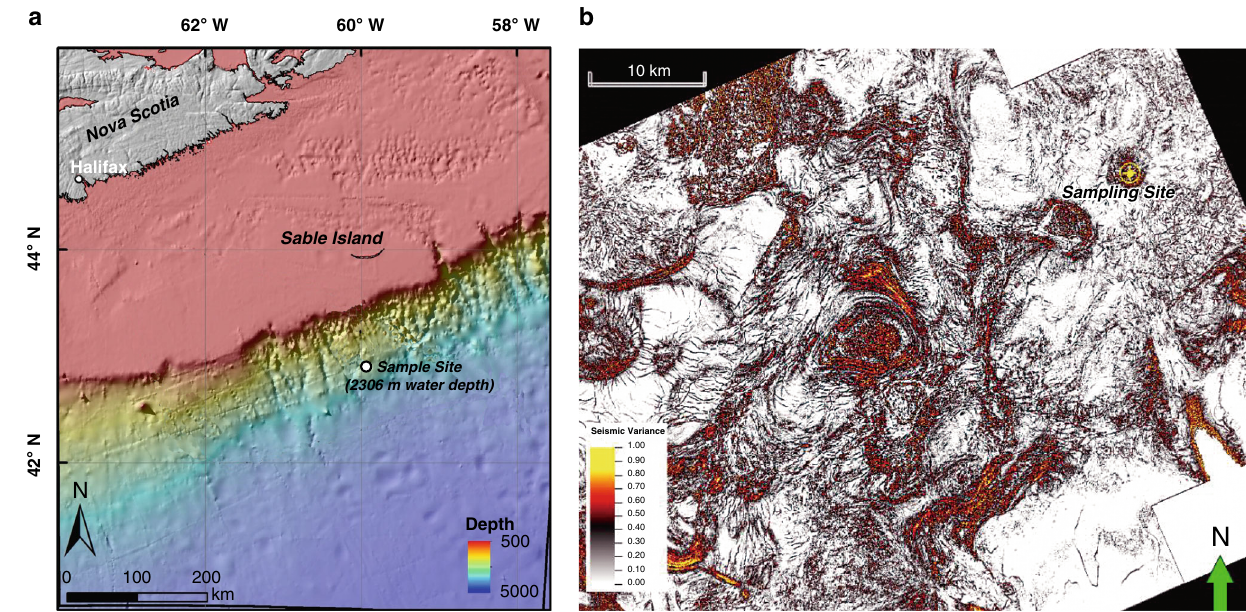
Fig. 1 Bathymetry and 3D seismic characterization of the study area. a Bathymetry of the Scotian Basin and the sediment sampling location. The Scotian Basin is in the northwest Atlantic Ocean, offshore Nova Scotia in eastern Canada. A 3.44-meter-long piston core was retrieved at a water depth of 2306 m. The map was generated using the ESRI ArcMap v10.6.1 software. The background bathymetry data were retrieved from General Bathymetric Chart of the Oceans (GEBCO) (https://www.gebco.net/data_and_products/gridded_bathymetry_data/documents/gebco_08.pdf). b Horizontal time slice through the Tangier 3D seismic survey at − 3500 m depth (i.e., approx. 1200 mbsf) with the variance (coherence) attribute shows salt diapirism throughout the Scotian Basin, including at the site chosen for the sediment core. Drawn with the Schlumberger Petrel v2018.1 software.